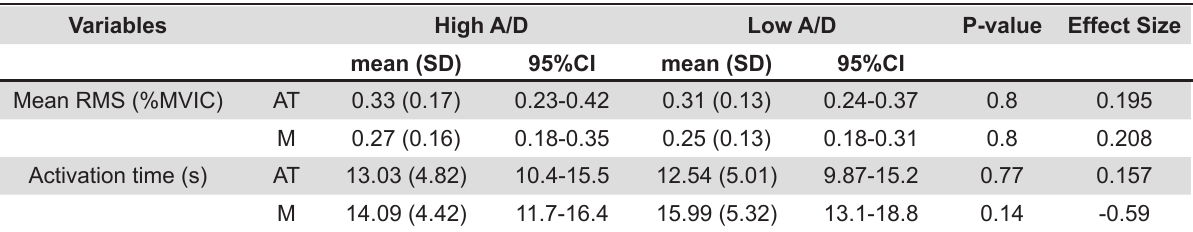
Table 2- Mean, standard deviation (SD), 95% confidence interval (CI), p-value and effect size of EMG data obtained during free chewing, recorded on the affected side (n=16)